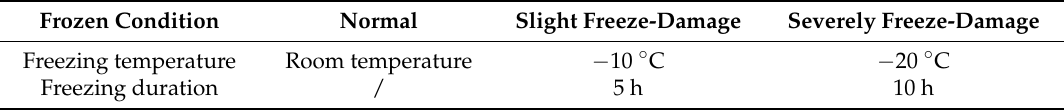
Table 7. The frozen condition (freezing temperature and freezing duration) of corn seeds. Frozen Condition Normal Slight Freeze-Damage Severely Freeze-Damage Freezing temperature Room temperature − 10 ◦ C − 20 ◦ C Freezing duration / 10